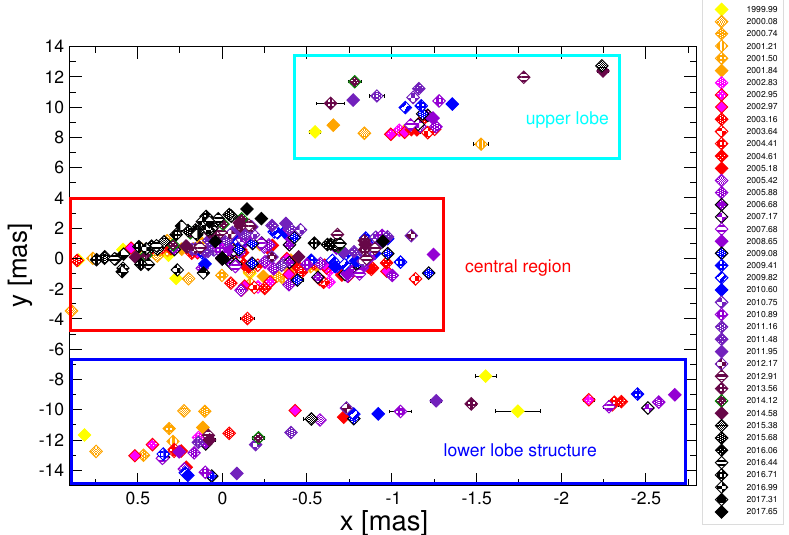
Figure 3. All the jet component positions of all the re-analyzed epochs are shown. We mark with a box (cyan) those components that belong to the upper lobe. The box in red marks the components that belong to the central region (zoom-in in Figure 4). The blue box marks the region with the lower lobe structure components.